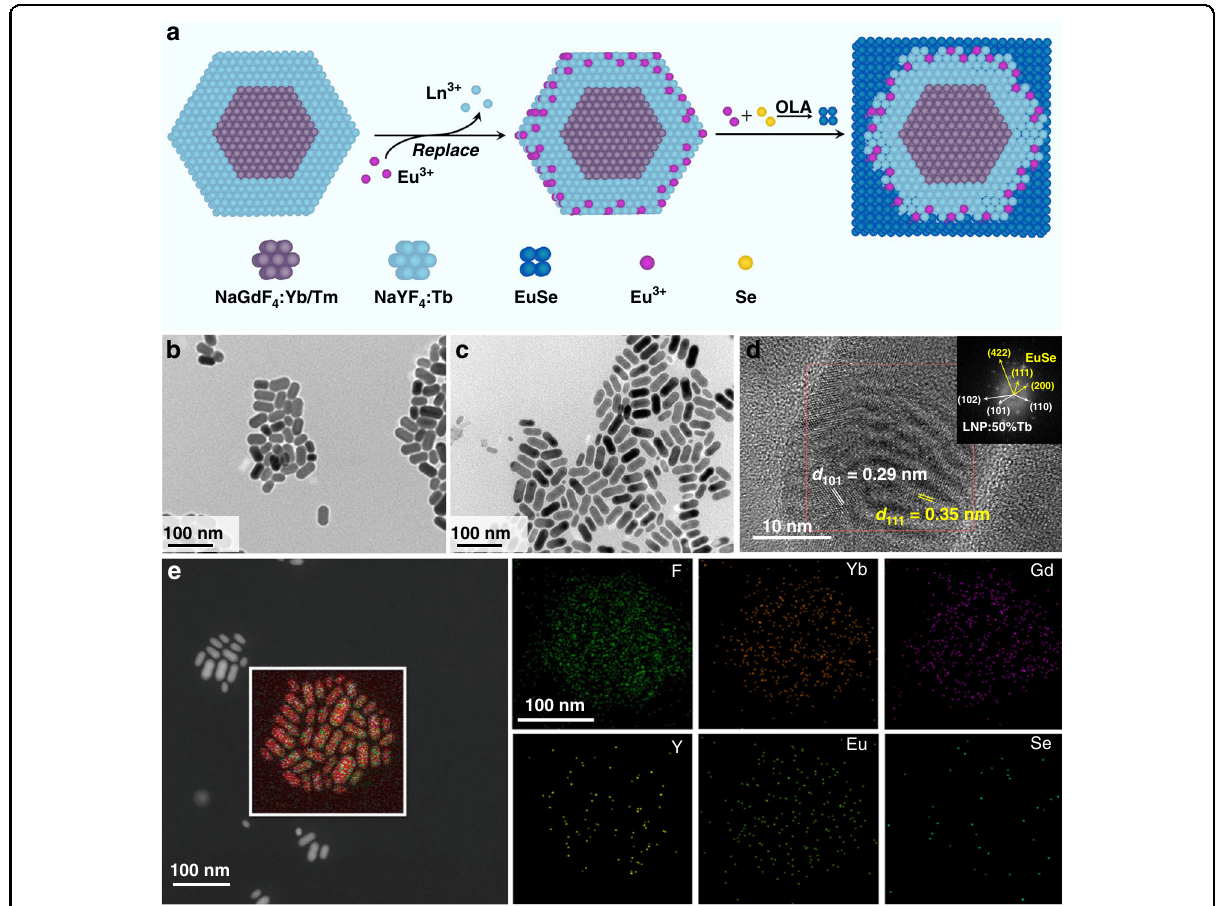
Fig. 1 Synthesis of NaGdF 4 :Yb,Tm@NaYF 4 :50%Tb@EuSe (denoted as LNP:50%Tb@EuSe) nanocomposite. a Schematic diagram of the design of EuSe growing on NaGdF 4 :Yb,Tm@NaYF 4 :50%Tb (denoted as LNP:50%Tb). b TEM image of LNP:50%Tb. c TEM image of LNP:50%Tb@EuSe. d HRTEM image of LNP:50%Tb@EuSe. Inset shows the corresponding Fourier transform diffraction pattern. e Scanning transmission electron microscopy image and element mappings of F, Gd, Yb, Y, Eu, and Se elements for